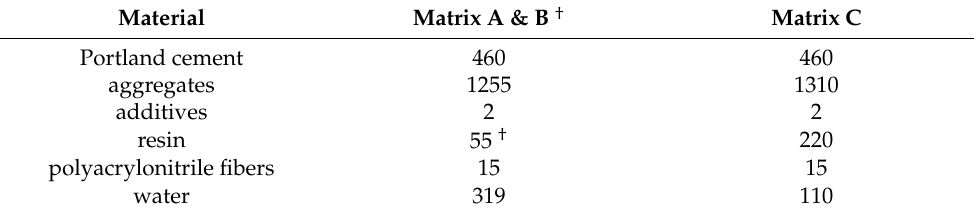
Table 3. Mix design (quantities in [kg/m 3 ] units) of the cement mortars. Material Matrix A & B † Matrix C Portland cement 460